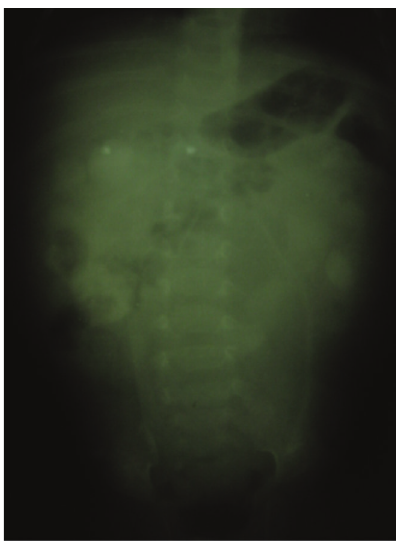
Figure 3: Preoperative intravenous urography showing a central cistern with diluted contrast.